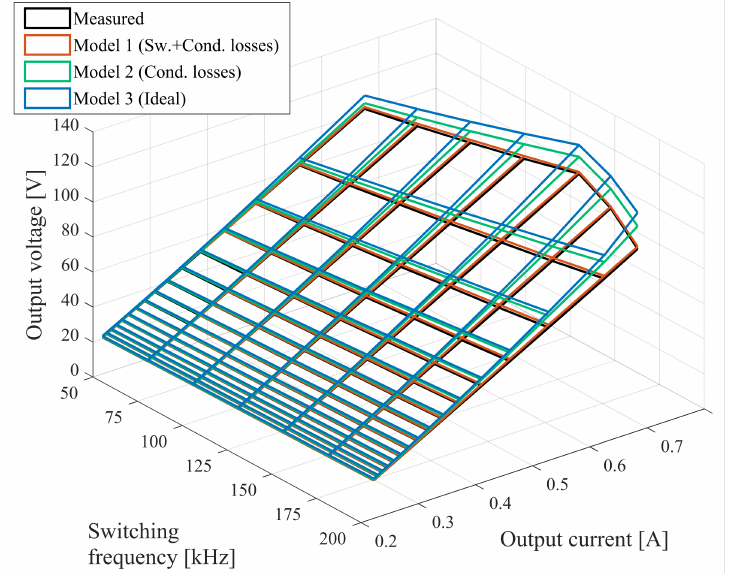
Figure 17. Predicted output voltage for known input voltage, input current and output